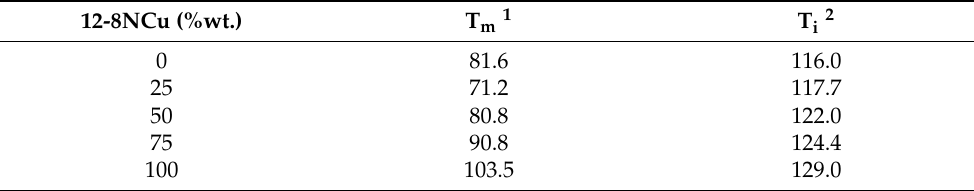
Table 2. Transition temperatures of binary mixtures of 12-8NCu/A6O-8NCu in weight percent ratio. 12-8NCu (%wt.)